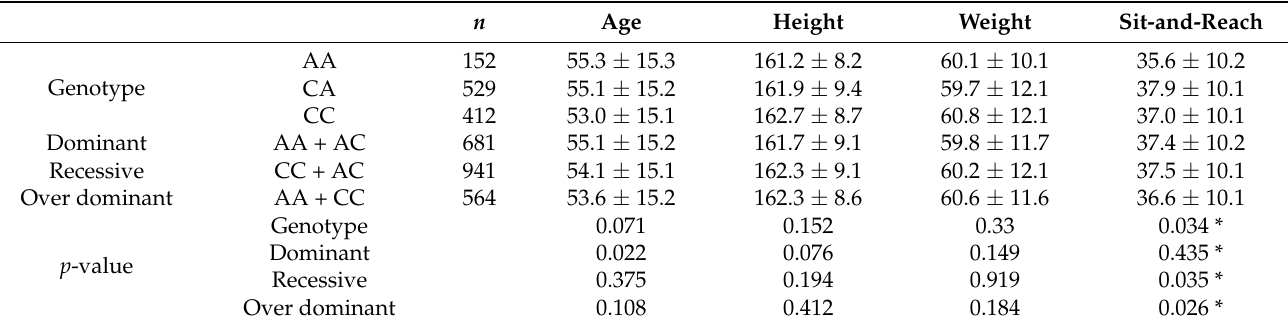
Table 3. Association between COL1A1 rs1107946 and sit and reach.